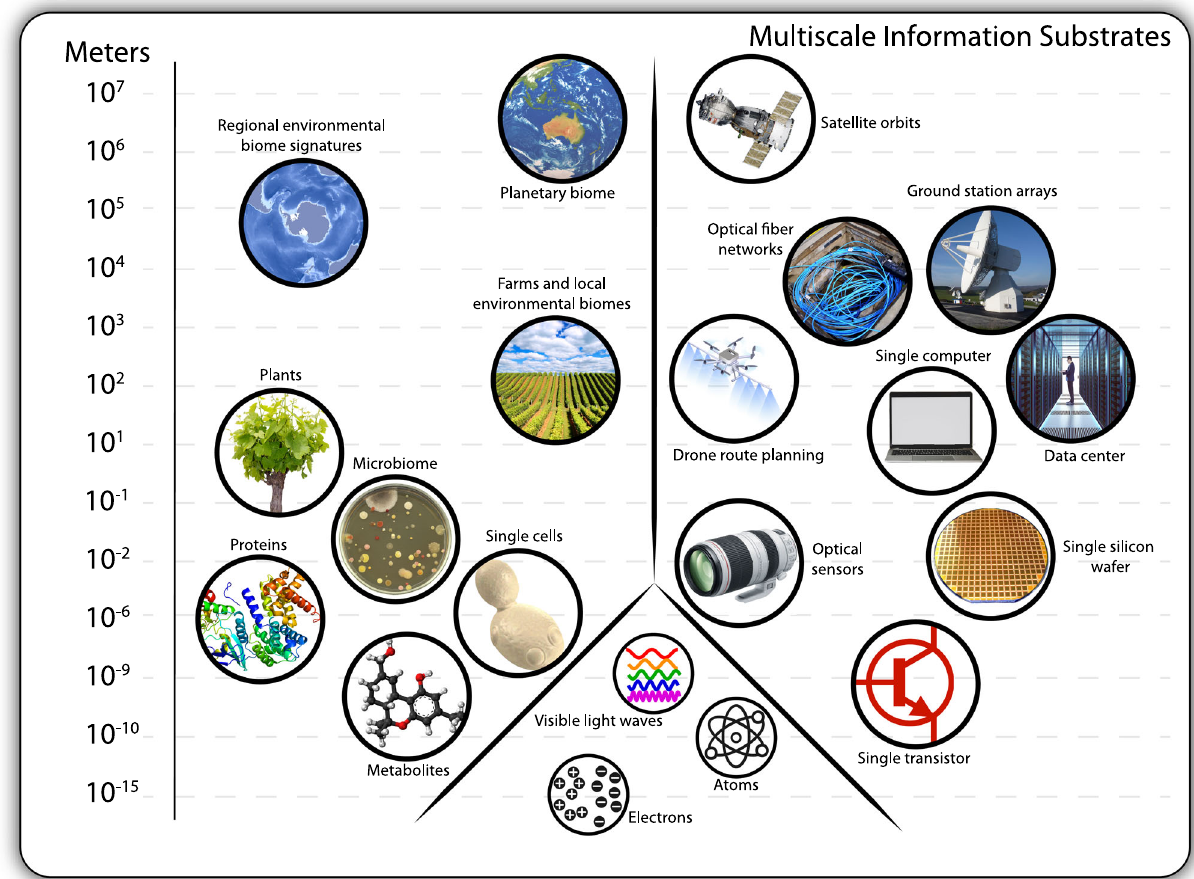
Fig. 1 Multiple length scale engineering across organic and inorganic information substrates. Engineering information communication across substrates interfaces a diverse array of systems over multiple length scales. Bio-informational system integrations operate across 10 − 15 m through to 10 7 m. To date, this process has primarily involved the collection of biological metadata via digital means. Developments in optogenetics and bioelectrochemistry suggest multiscale engineering may become a two-way communication